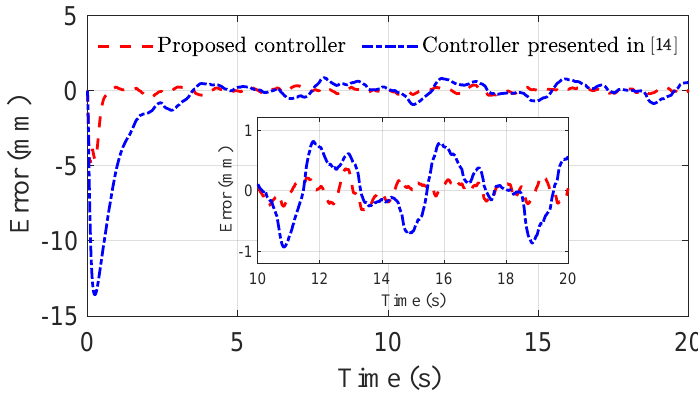
Figure 10. Error comparison of quarter vehicle with AAS in co-simulation.